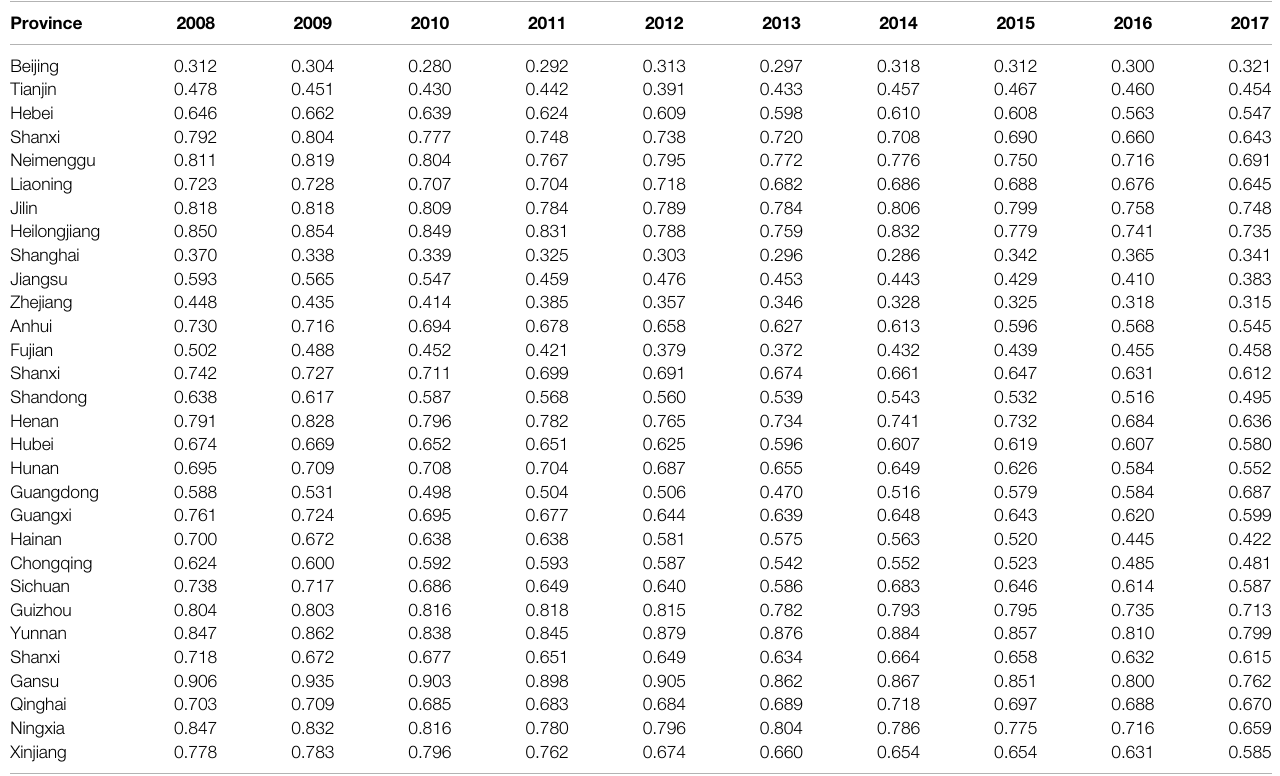
TABLE 2 | Energy poverty index of China ’ s provinces from 2008 to 2017.